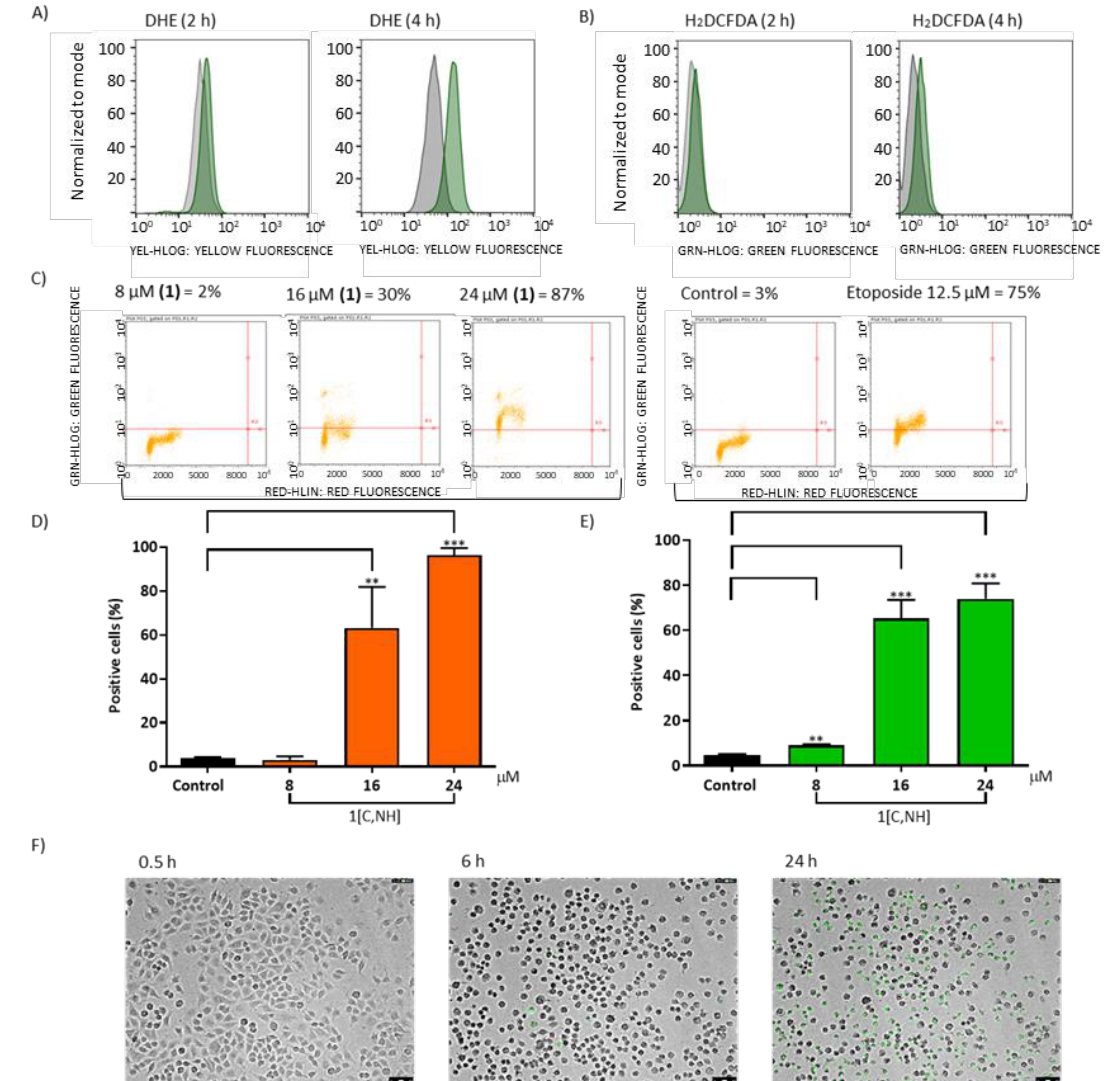
Figure 6. ( A ) O 2 • - production after 2 h and 4 h incubation in A549 cells with 1[C,NH] and detection using DHE by flow cytometry. ( B ) ROS production (H 2 O 2 included) after 2 h and 4 h incubation in A549 cells with 16 µ M of 1[C,NH] and detection using H 2 DCFDA by flow cytometry. Green profile = 1[C,NH] , Gray profile = Vehicle. 5000 stained cells were analyzed using the Guava EasyCyte flow cytometer and processed with the FlowJo program. Increases in fluorescence are indicative of increased ROS production. Images were representative of at least three independent experi- ments. ( C ) Percentage of A549 positive cells to damage on DNA analyzed by flow cytometry. Cells were treated for 4 h at the indicated doses of 1[C,NH] (left). Untreated cells (control) and treated cells with Etoposide (positive control). ( D ) Cardiolipin oxidation. Percentage of positive cells. A549 cells were analyzed by flow cytometry after 4h incubation at the indicated concentrations of 1[C,NH] . Data shown are the mean and SD of at least three independent experiments (** p < 0.01), *** p < 0.001; ( E ) Release Cytochrome c. Percentage of positive cells were measured using Millipore’s FlowCellect Cytochrome C Kit. A549 cells were incubated for 5 h at the indicated concentrations of 1[C,NH] and analyzed by Flow Cytometry. Data shown are the mean and SD of at least three independent experiments (** p < 0.01, *** p < 0.001). ( F ) Caspase activity was determined using CellEvent Caspase 3/7 Green Detection Reagent. A549 cells were treated with 16 µ M of 1[C,NH] and observed using fluorescence microscope for 24 h. Images were captured at indicated incubation time. Green fluorescence emission indicates caspase activity (caspases 3/7). Magnification (10 ×